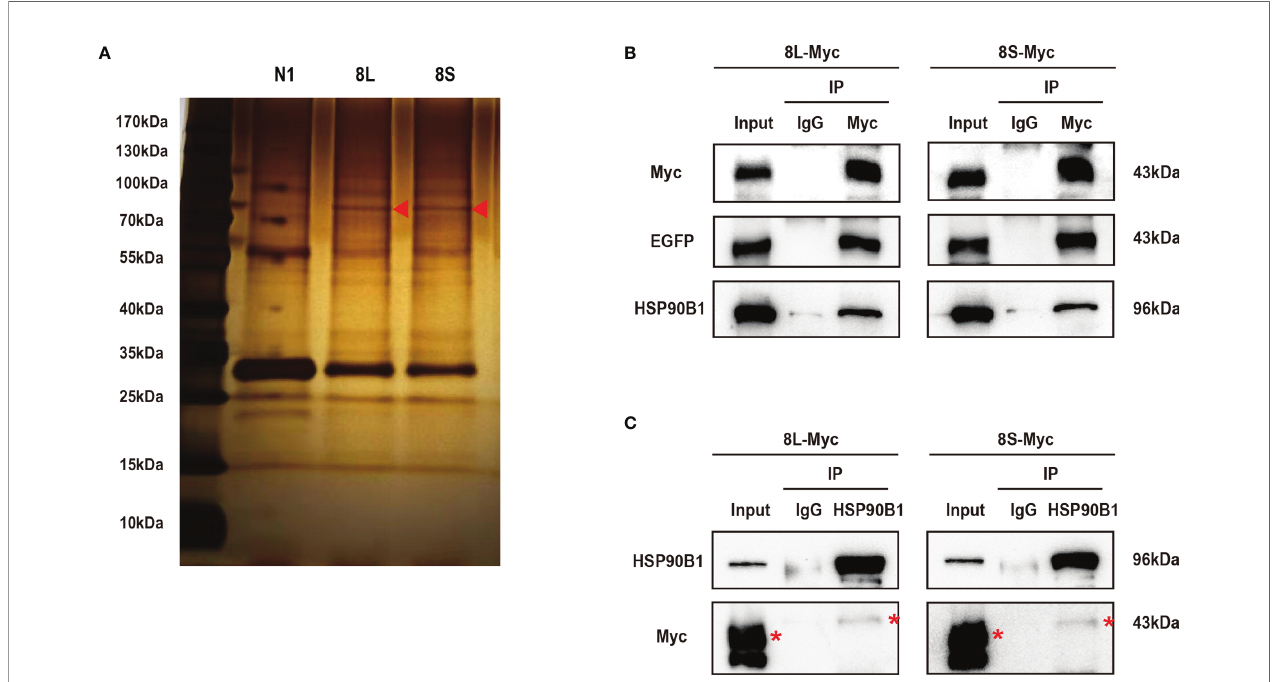
FIGURE 5 | The SARS-CoV-2 ORF8L and ORF8S proteins interact with HSP90B1. (A) The HEK293T cells were transfected with pEGFP-ORF8L and pEGFP- ORF8S for 48 h. The cell lysates were immunoprecipitated with anti-GFP pAb and then were separated by SDS-PAGE, followed by silver staining and LC-MS/MS. Shown are the differential protein bands between EGFP-8L- or EGFP-8S- and EGFP-expressing cells. Red triangles indicate the band from which HSP90B1 was identi fi ed. (B) The HEK293T cells were transfected with pEGFP-ORF8L-Myc and pEGFP-ORF8S-Myc for 48 h. The cell lysates were co-immunoprecipitated with anti-Myc antibody and detected with anti-Myc, anti-EGFP, and anti-HSP90B1 antibody by Western blot. (C) The indicated plasmids were transfected into HEK293T cells before co-immunoprecipitation with anti-HSP90B1 antibody and were analyzed by Western blot with anti-Myc antibody. Red asterisks indicate the target band. Co-immunoprecipitation results are representative of two independent experiments. pEGFP-ORF8L-Myc, 8L-Myc; pEGFP-ORF8S-Myc,